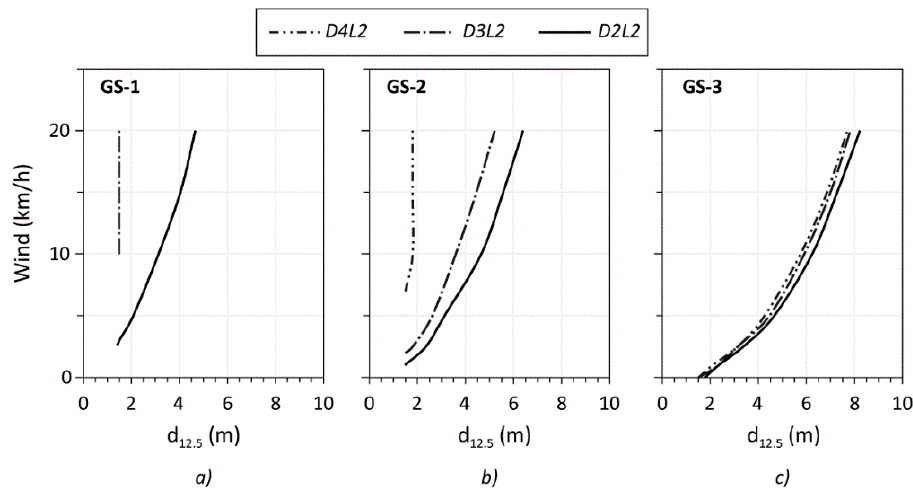
Figure 9. Safe separation distances as a function of wind speed at Low MC (D2L2) for GS fuel models.